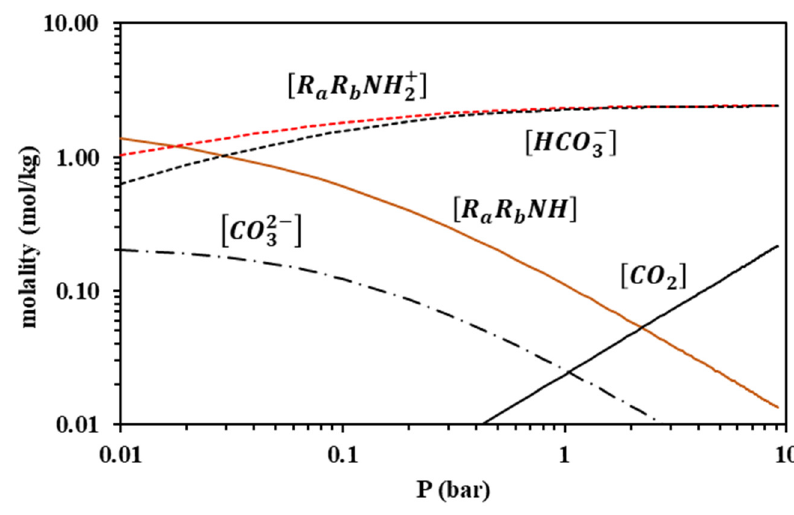
Figure 12. Liquid-phase speciation for AMP-CO 2 -H 2 O system at 313 K, predicted using the modified Kent-Eisenberg model (calculations performed for the CO 2 loading of 17.7% wt. AMP aqueous solutions).